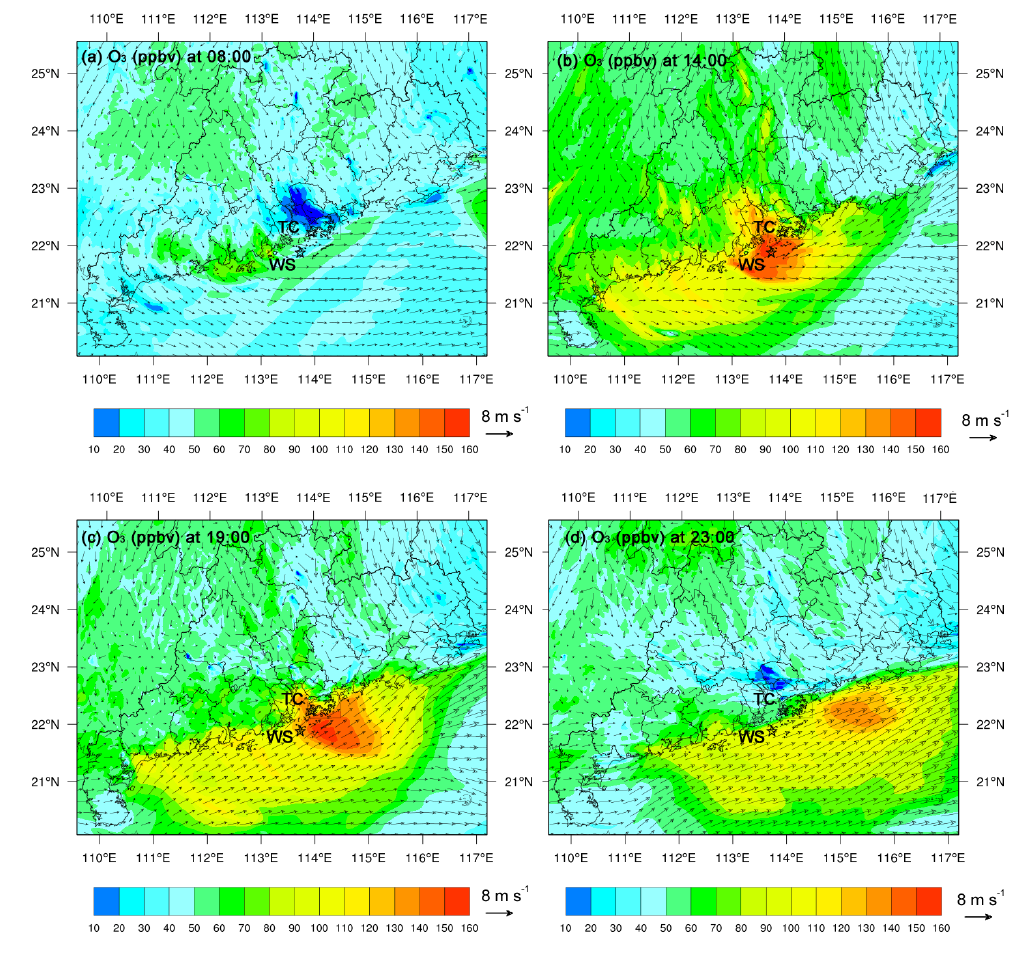
Figure 7. Spatial distribution of O 3 at 08:00 (a) , 14:00 (b) , 19:00 (c) and 23:00 (d) on 21 August simulated by WRF-CMAQ, taken as an example of the “outflow” interaction pattern. Arrows in the figure represent the surface wind